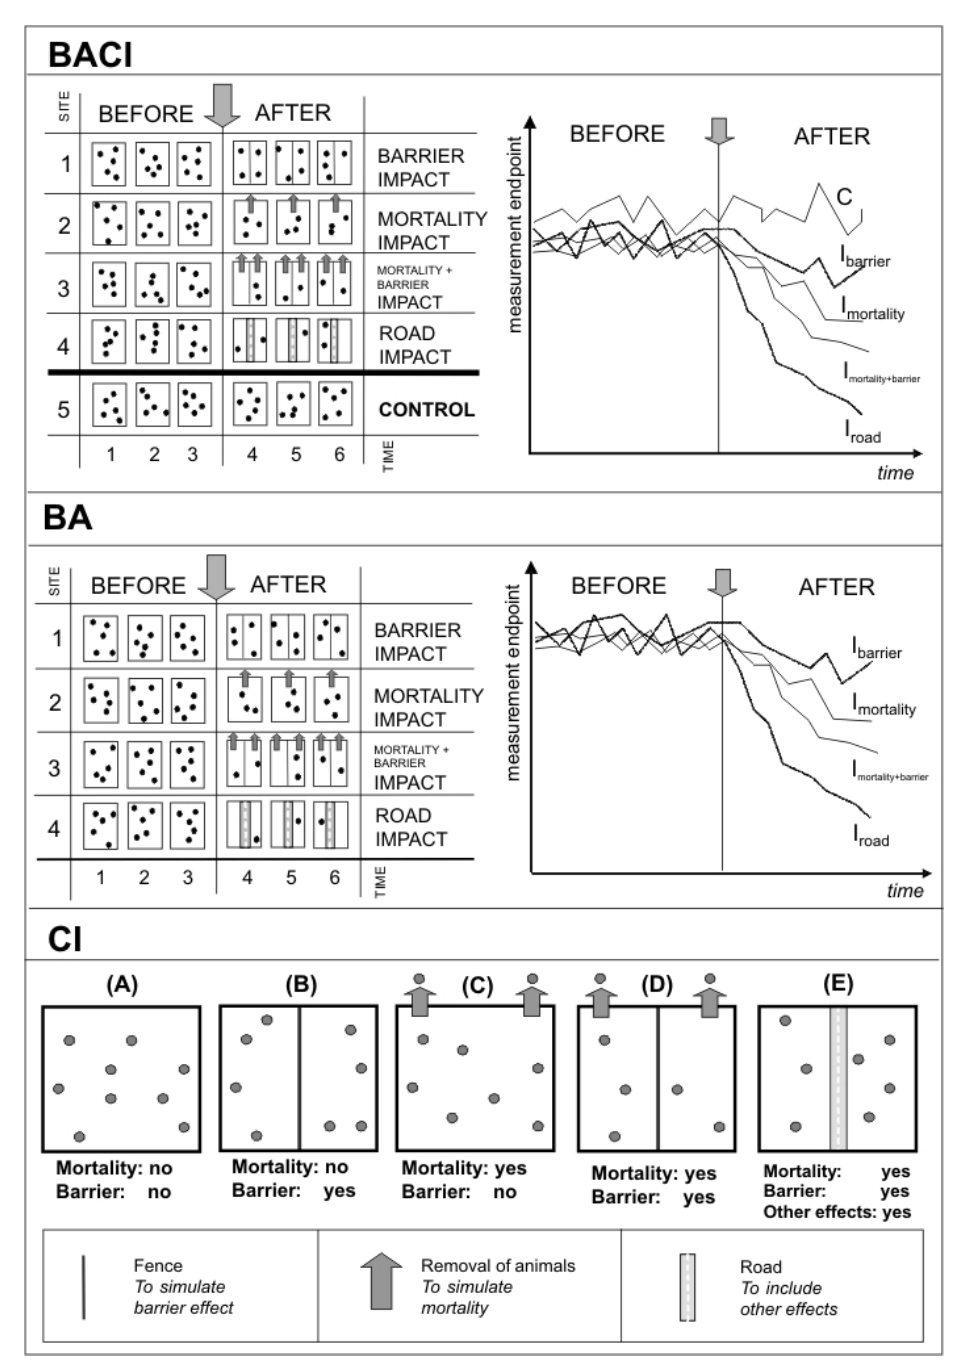
Fig. 6 . Study designs and hypothetical results for Question 4: What is the relative importance of the different mechanisms by which roads affect population persistence? The study types include before- after-control-impact (BACI), before-after (BA), and control-impact (CI)